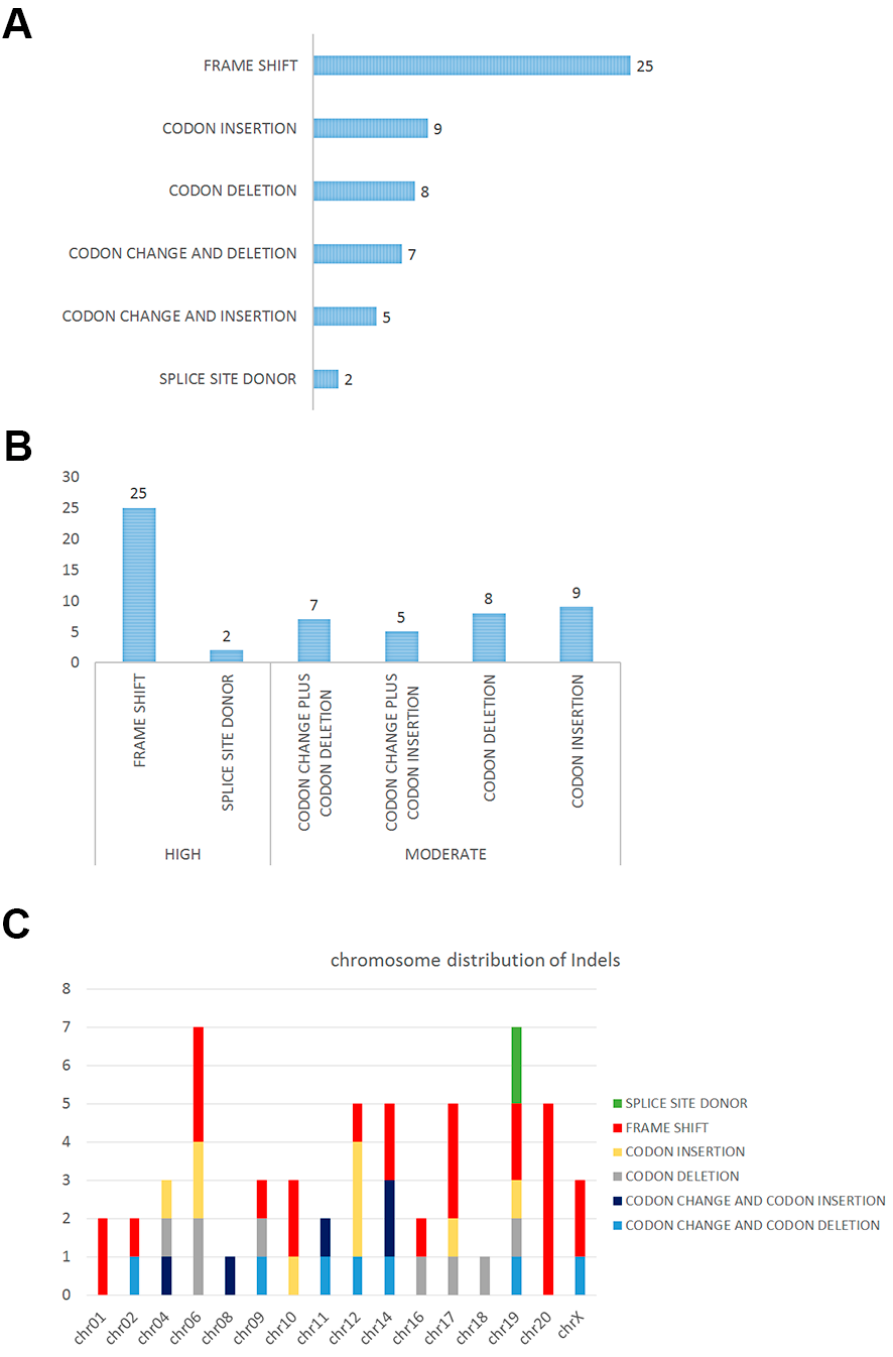
Figure 2. Functional annotation of indels detected in solid pseudopapillary tumor of the pancreas: ( A ) Indels would introduce frame shift, codon insertion, codon deletion, codon changes and deletion, codon changes and insertion and splicing alteration; ( B ) high and moderate impact of each indels by predicting; and ( C ) indels with different impact depth distributed in chromosomes.